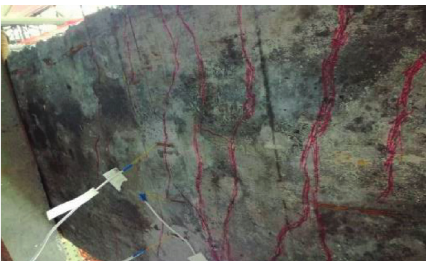
Figure 11: Interconnected fractures at the bottom of LPCSHTHSC.